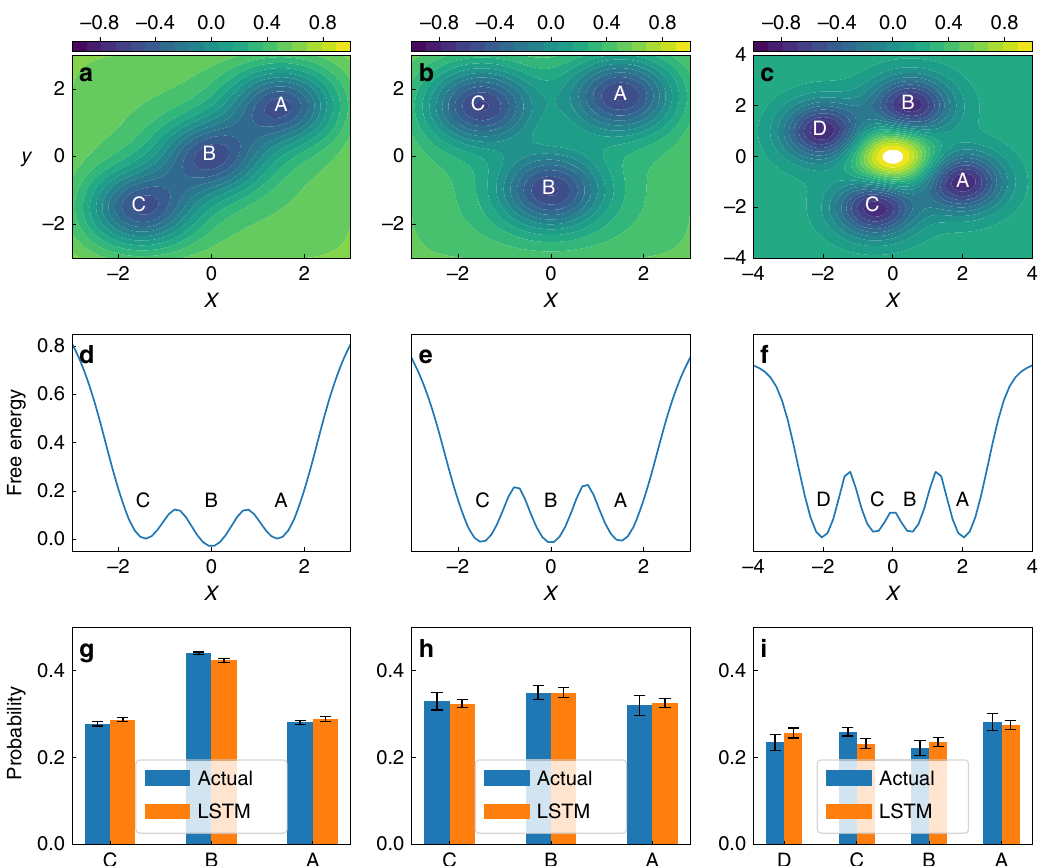
Fig. 2 Boltzmann statistics for model systems. The analytical free energy generated from a linear 3-state, b triangular 3-state, c symmetric 4-state model potentials and d , e , f are the corresponding 1-dimensional projections along x -direction. In the bottom, we compare the Boltzmann probabilities of g linear 3-state, h triangular 3-state, and i symmetric 4-state models for every labeled state generated from actual MD simulation and from our long short-term memory (LSTM) network. The errorbars are calculated as standard